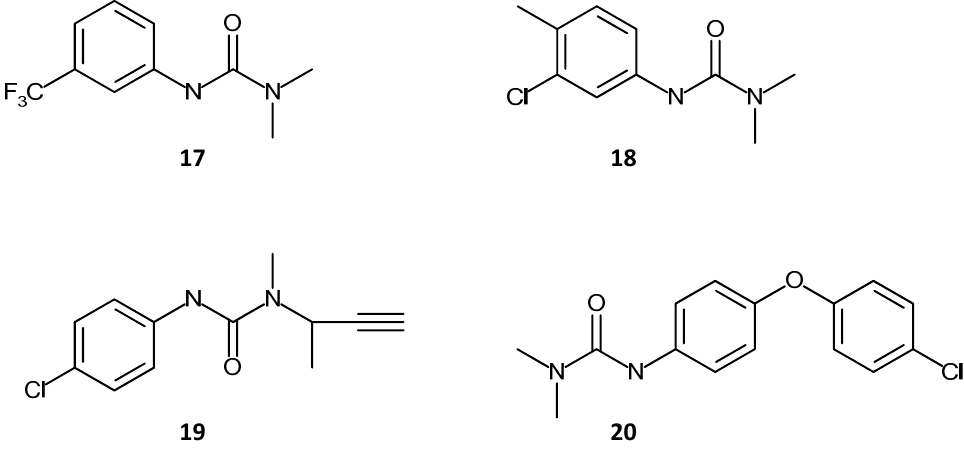
Figure 9. Chemical structures of herbicides (( 17 ) fluometuron; ( 18 ) chlortoluron; ( 19 ) buturon and ( 20 ) chloroxuron), used by Lin et al. [124].